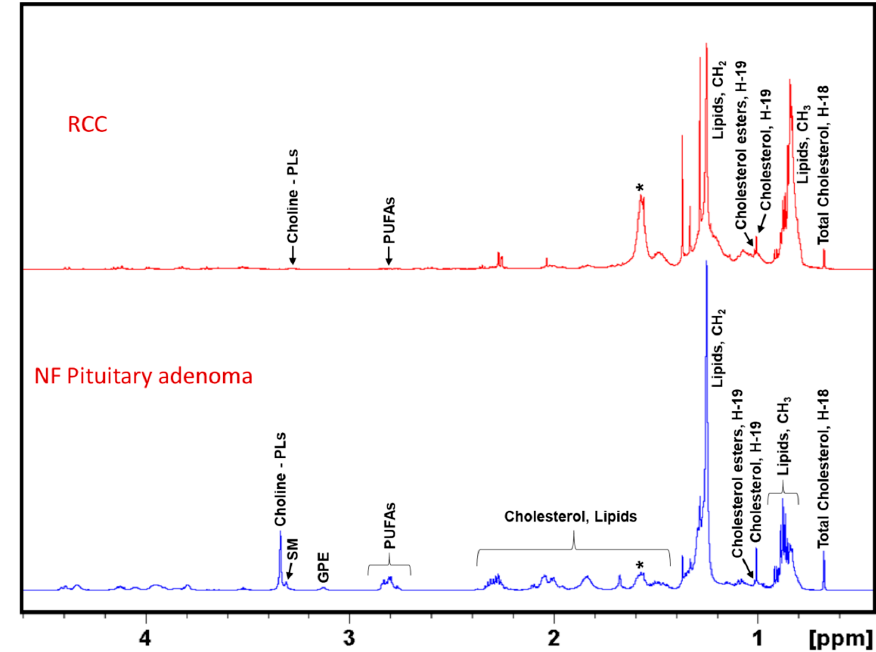
Figure 4. Representative 1 H NMR spectra of lipid extracts of NF pituitary adenoma and RCC. NF Pituitary adenoma shows the presence of cholesterol, cholesterol esters, PUFAs, glycerophosphoethanolamine (GPE), choline-containing phospholipids (Choline-PLs), sphingomyelin (SM), whereas RCCs showed the presence of mostly cholesterol and low levels of cholesterol esters, PUFAs and Choline-PLs. The asterisk (*) shows the presence of residual water in the NMR solvent, CDCl 3 .